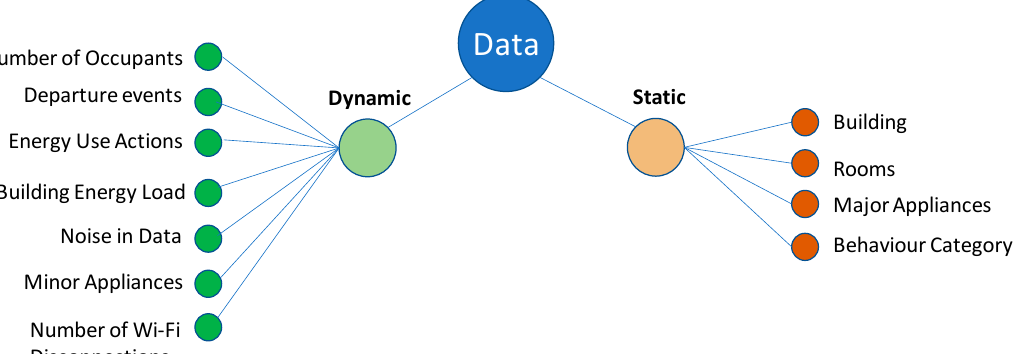
Figure 7. Diagram of data types in a building [65].